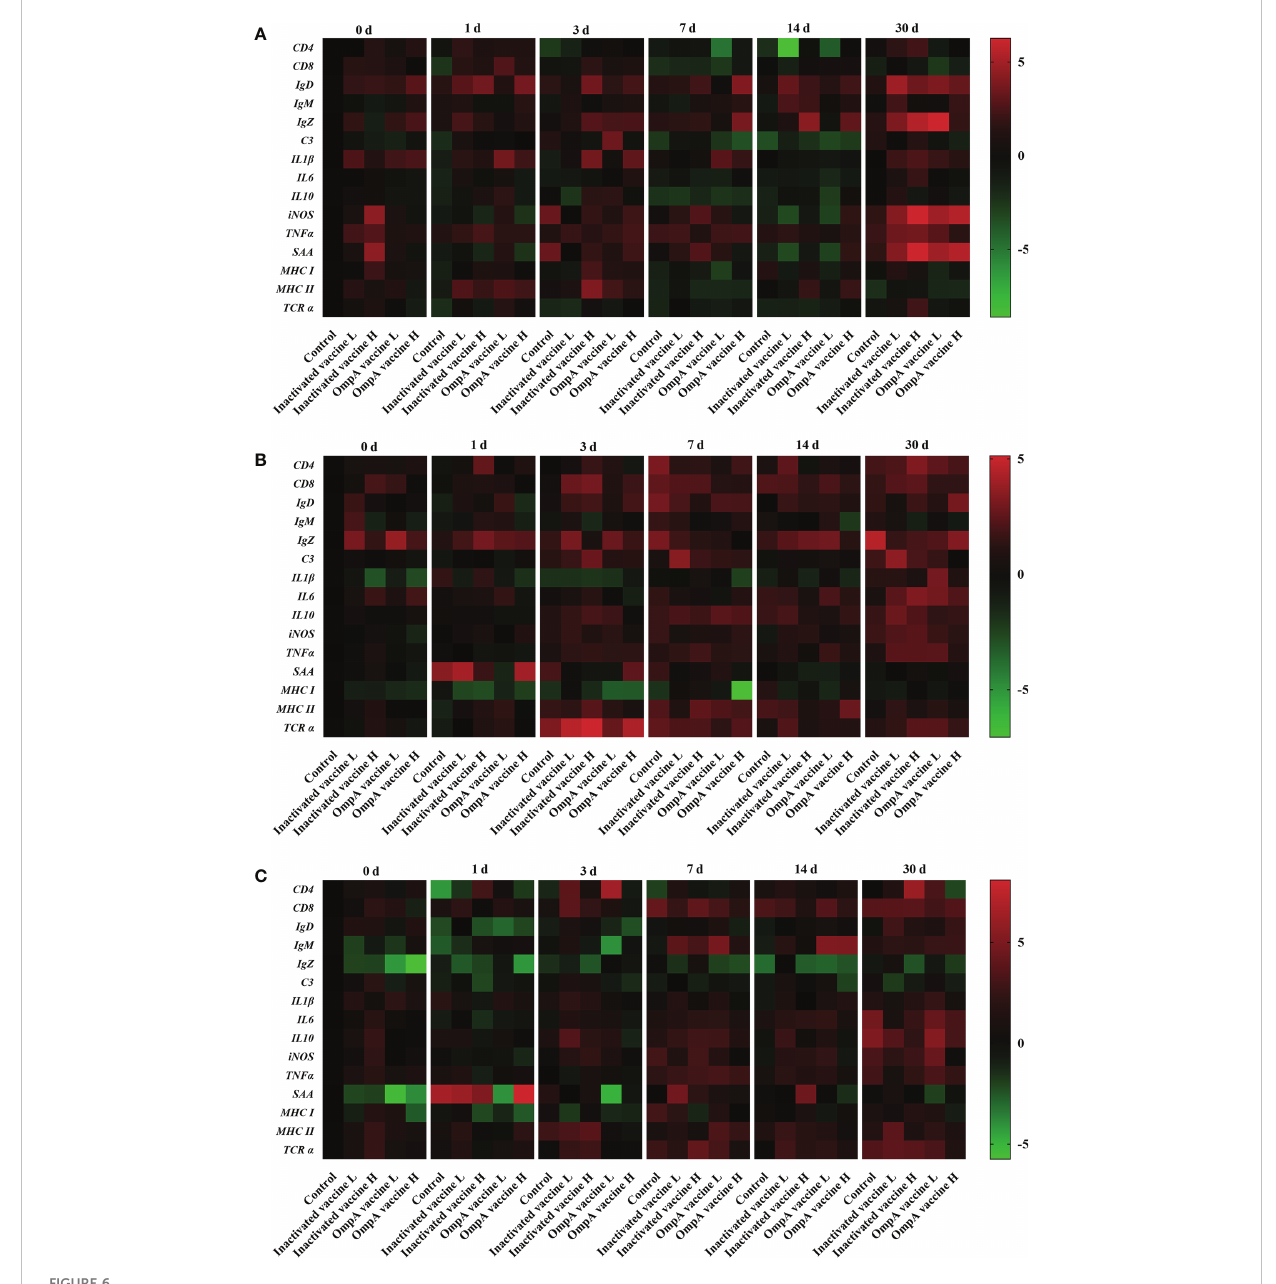
FIGURE 6 Heatmaps illustrate results from qRT-PCR for the expression of immune related genes in the intestines (A) , gills (B) and hepatopancreas (C) of juvenile M. amblycephala . Color value: log2 (fold